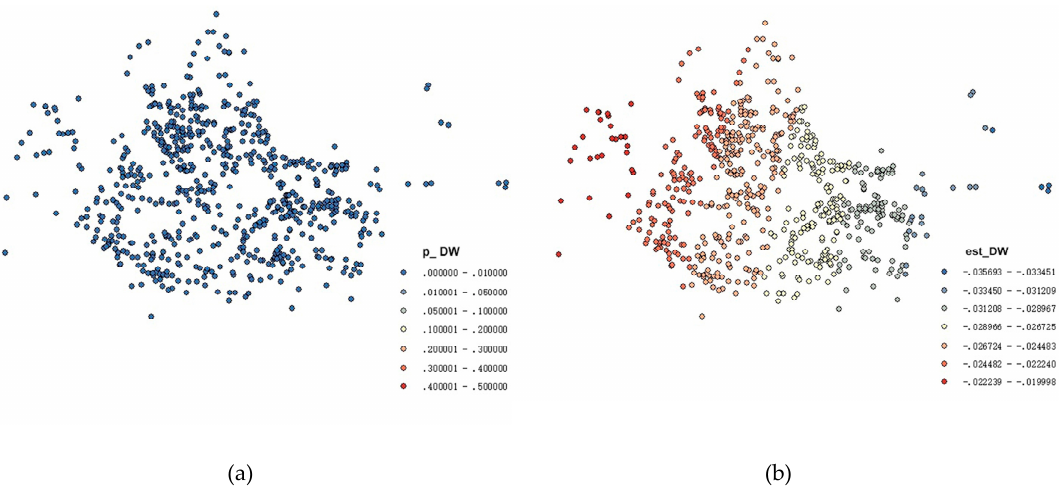
Figure 3. P-value ( a ) and regression coefficient distribution ( b ) of distance to water system.